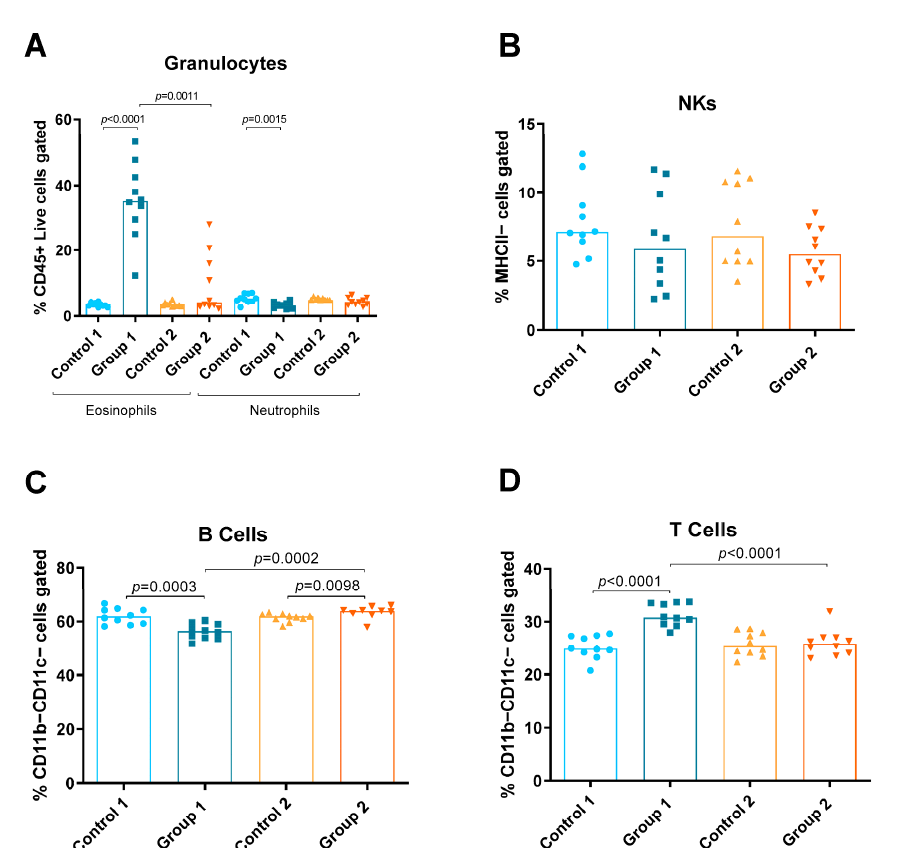
Figure 2. Granulocyte, natural killer (NK) cell and lymphocyte levels in lung homogenates from flow cytometry analysis. Experimental groups are the same as in Figure in Section 4.3. In each group, data are shown as individual and median values of eosinophils and neutrophils ( A ), NK cells ( B ), B cells ( C ) and T cells ( D ).